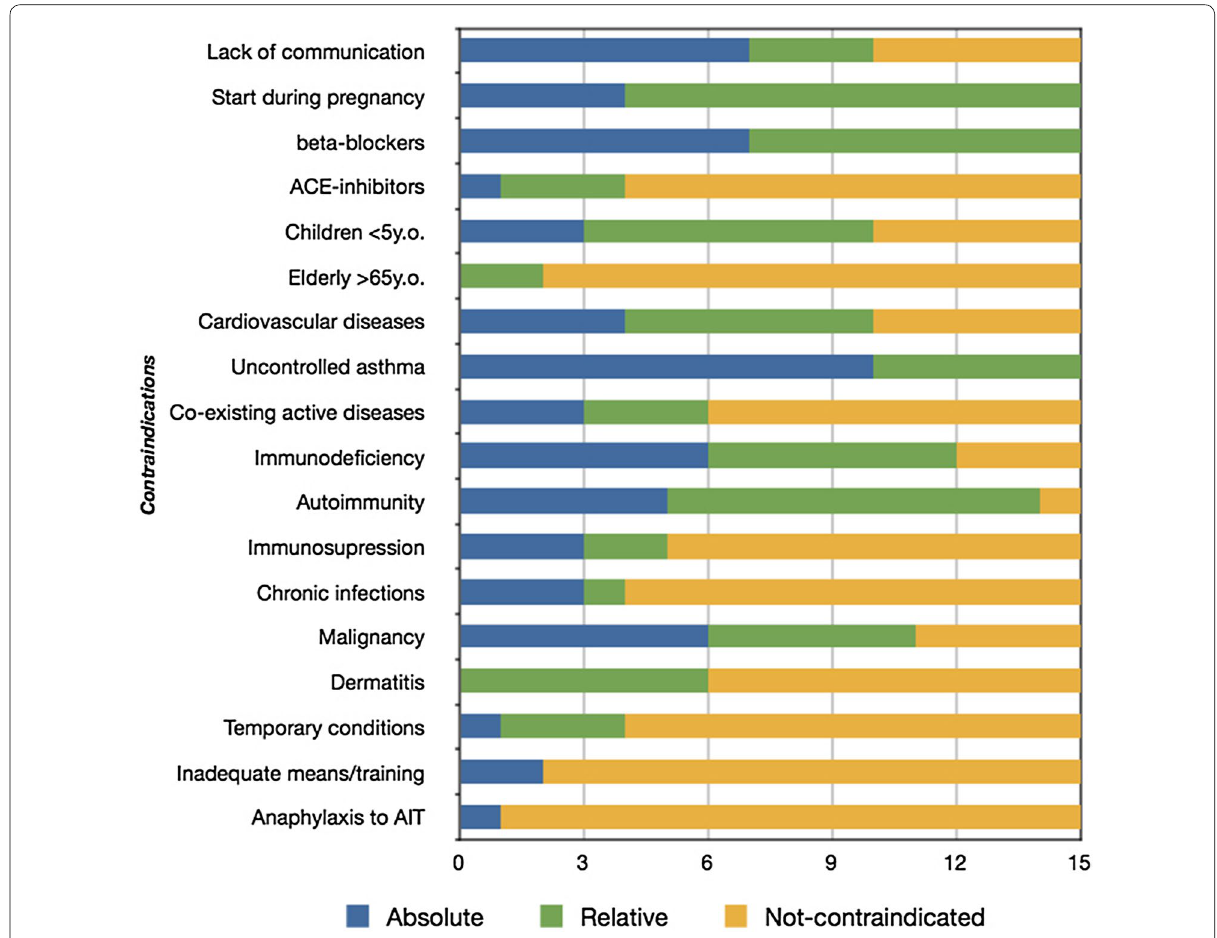
Fig. 2 Conflicting guidelines on whether a condition/comorbidity consists absolute, relative or no contraindication to